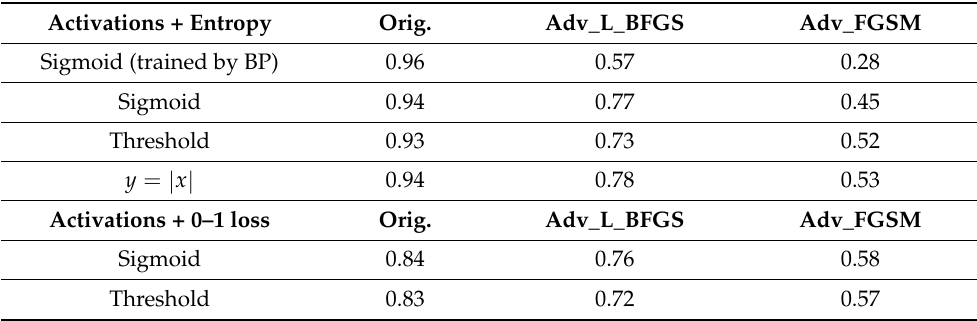
Table 2. The results of adversarial tests for two hidden layers artificial neural network trained by the GLR with different activation and loss functions in [161].